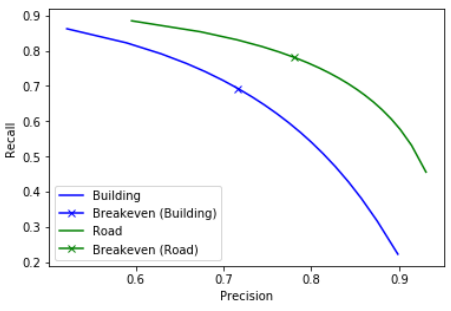
Figure 8. Recall-Precision curve of the trained deconvolutional